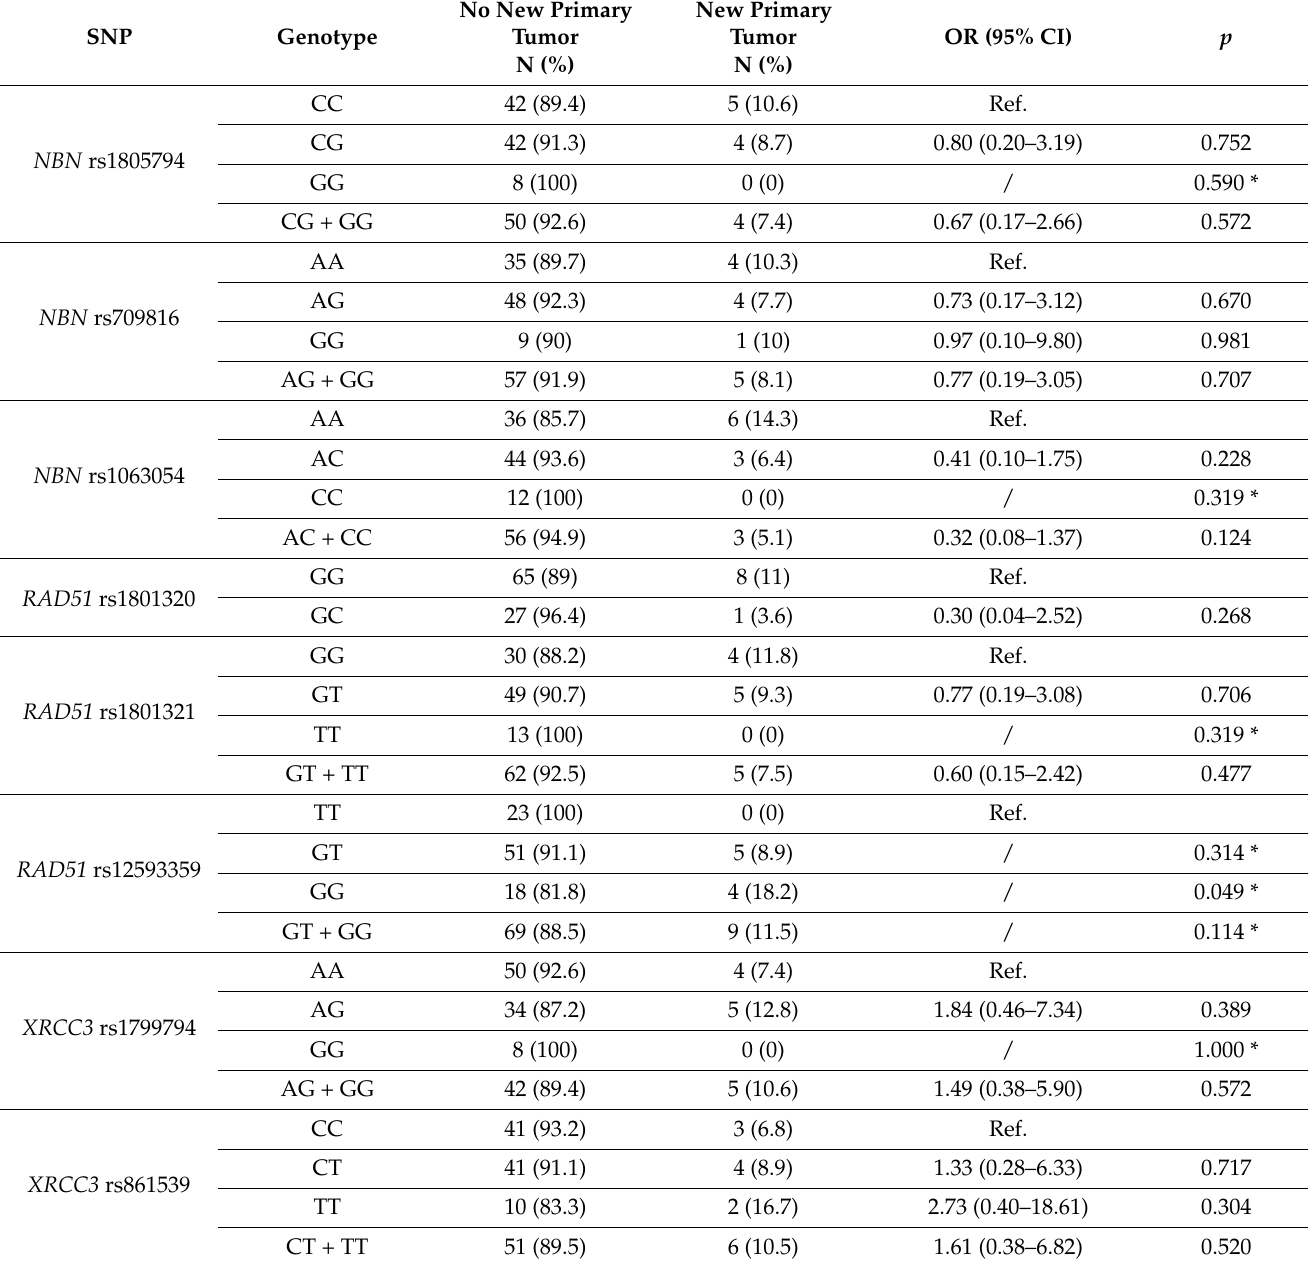
Table 8. Association of selected polymorphisms in HRR genes with the occurrence of a new primary